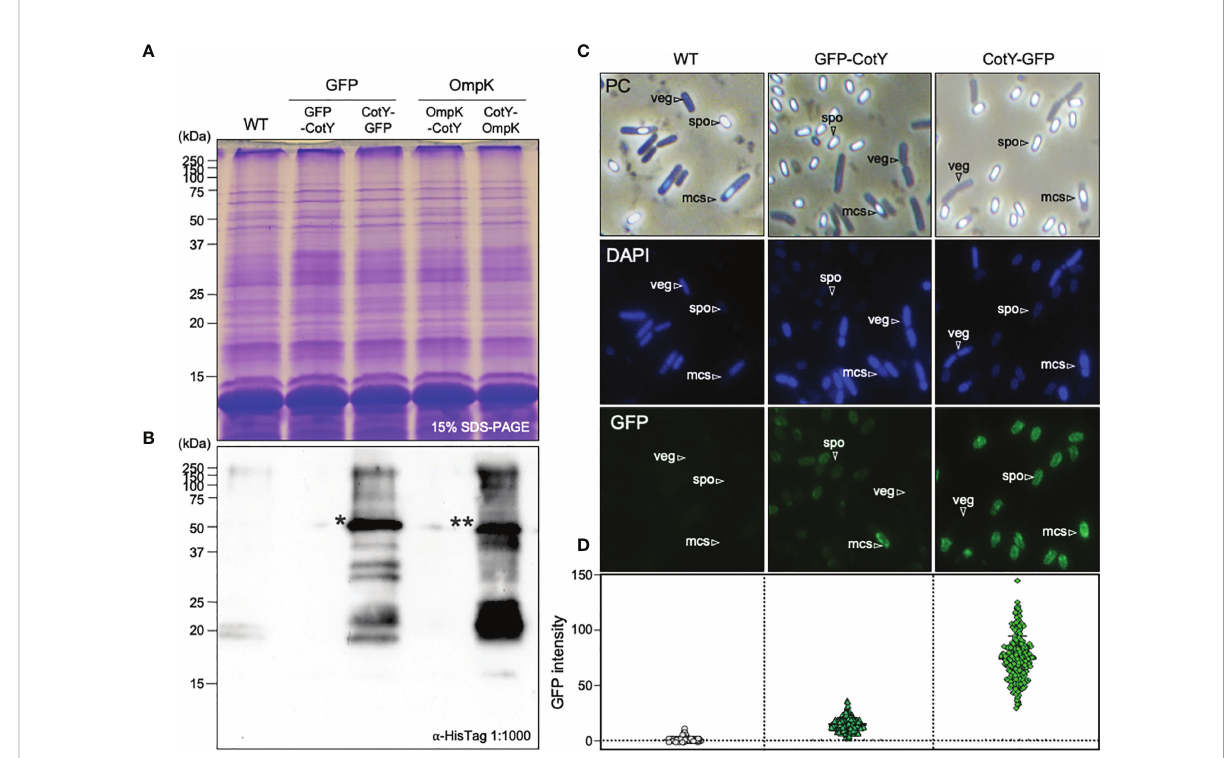
FIGURE 1 Detection of GFP and OmpK proteins at the surface of B subtilis spores. (A) Spore proteins from B subtilis 168 (WT) and its congenic derivatives bearing the N- and C-terminal fusions of GFP (CRS219, CRS218) and OmpK (CRS221 and CRS222) to CotY, were separated in a 15% acrylamide gel, all revealing a similar pattern. (B) Western blot analysis using an anti-HisTag primary antibody (1:1000) detected two bands (indicated asterisks) of approximately 46KDa equivalent to the sum of the MW of CotY (18KDa) and H6-GFP (28KDa) indicated as * or H6-OmpK (28 KDa) indicated as ** in the C-terminal clones. The molecular weight marker (MWM) sizes are indicated in KDa. (C) Phase-contrast (PC) and fl uorescence microscopy images of 24h cultures of B subtilis 168, CRS218 and CRS219 grown in DSM at 37°C and 150 rpm, stained with DAPI for detecting the nucleoid. Vegetative cells (veg), sporulating cells (mcs) and free mature spores (spo) are indicated. (D) GFP signal intensity quanti fi cation in 200 cells per strain with ImageJ software